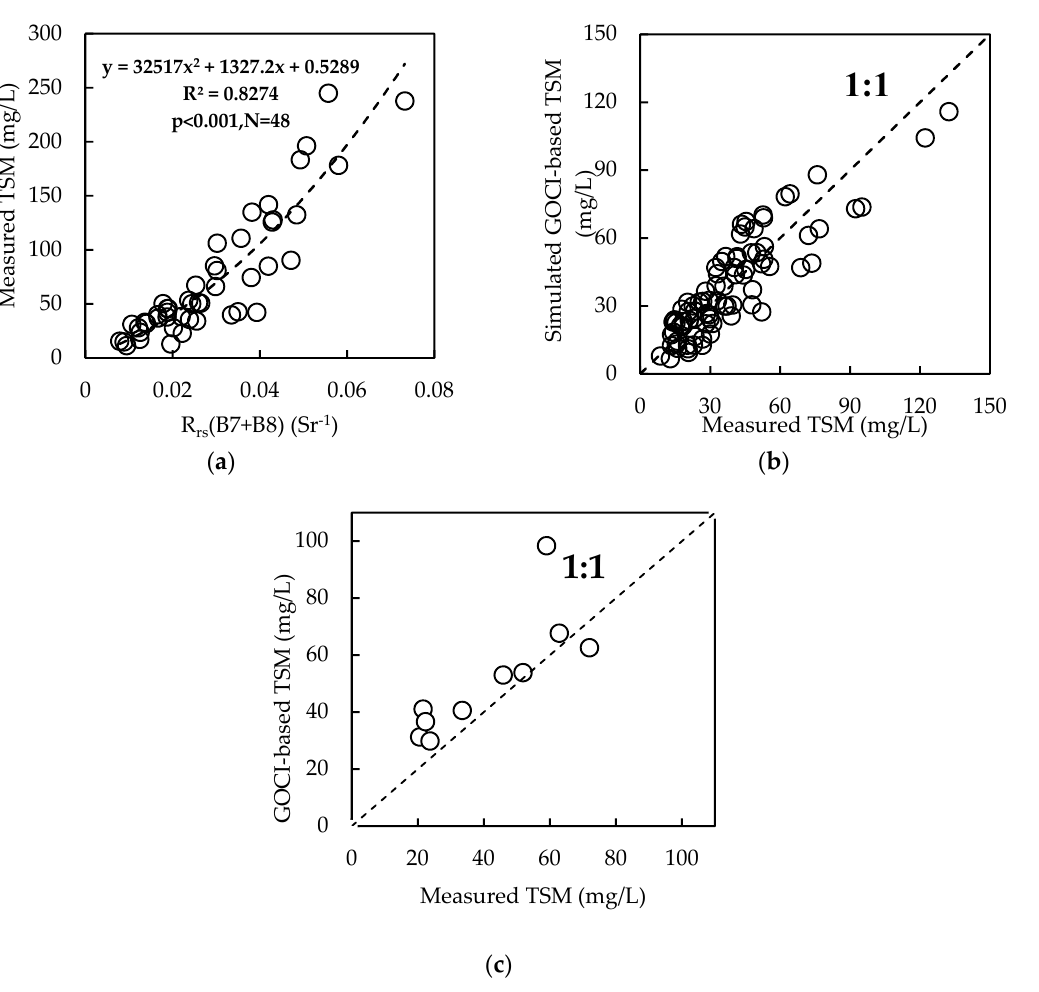
Figure 3. Calibration ( a ) and validation ( b , c ) of the proposed model for estimating TSM in turbid Lake Taihu.